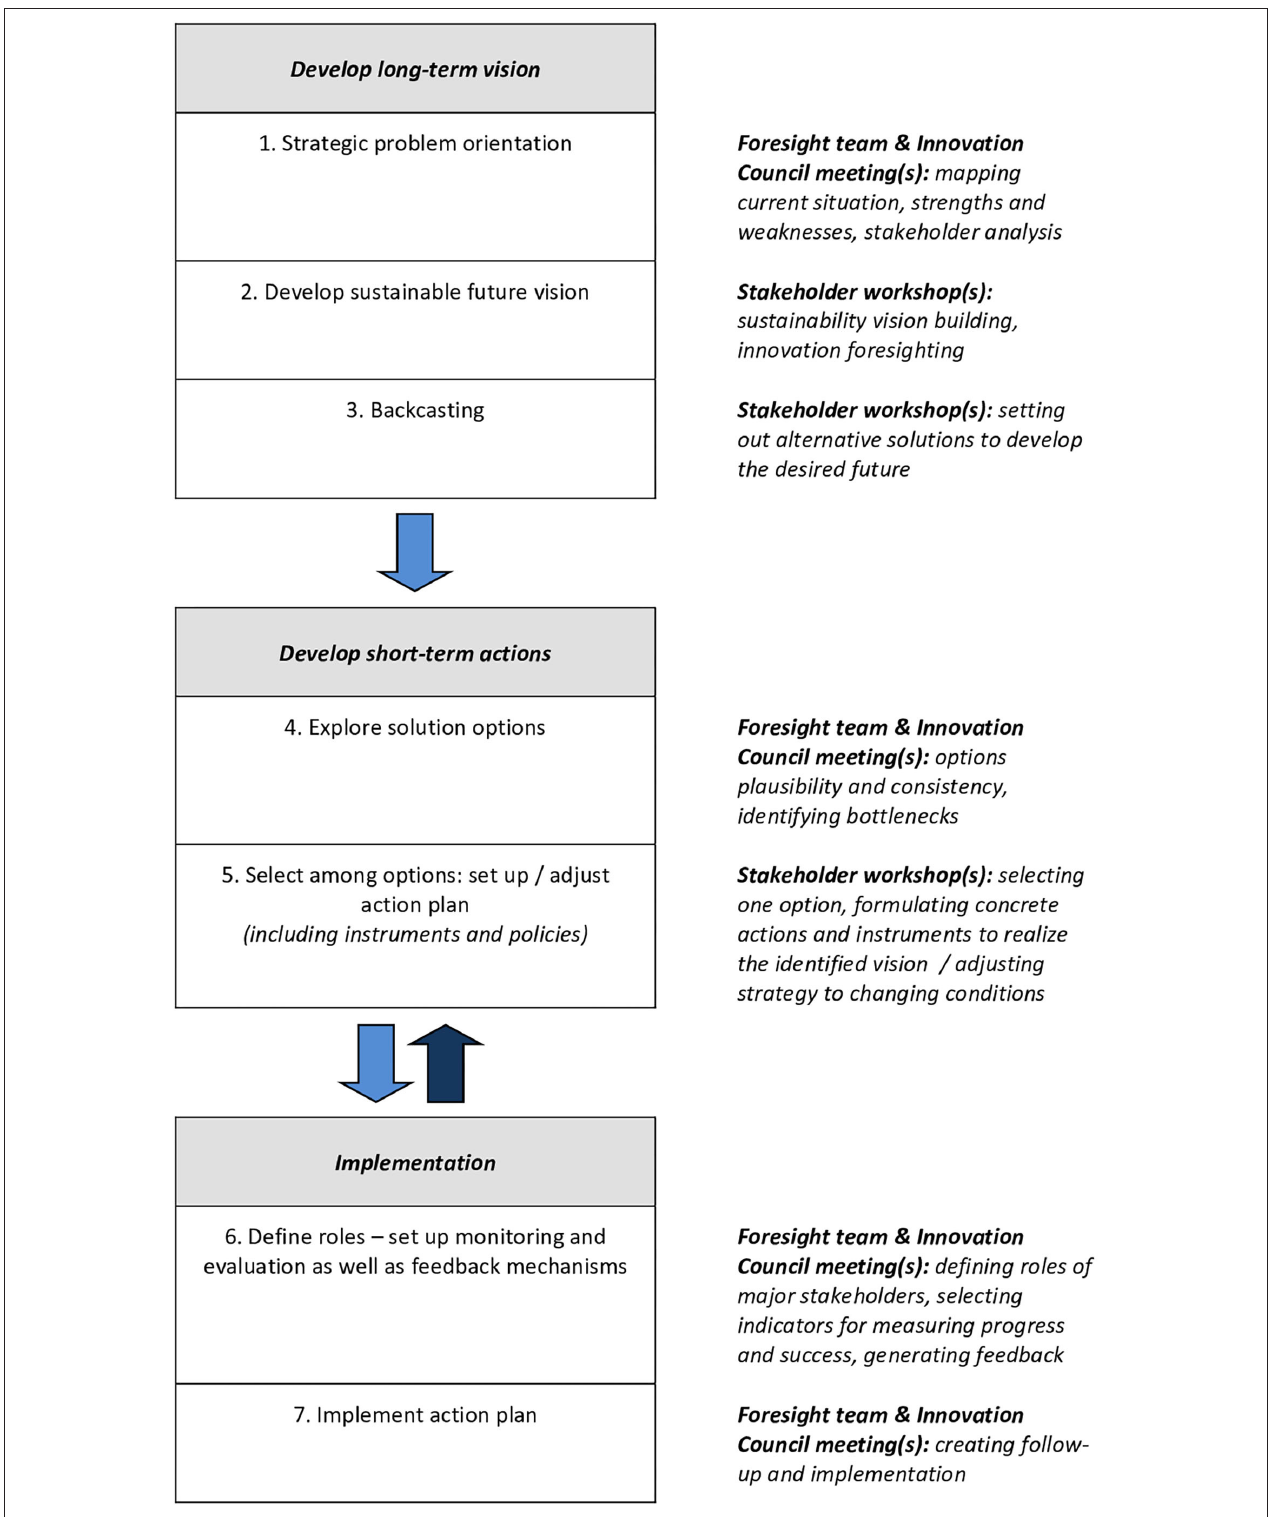
FIGURE 1 | Key steps of the proposed foresight methodology, which also includes a feedback loop to shape innovation policy mixes over time; adapted from Jezic von Gesseneck et al. (2018).